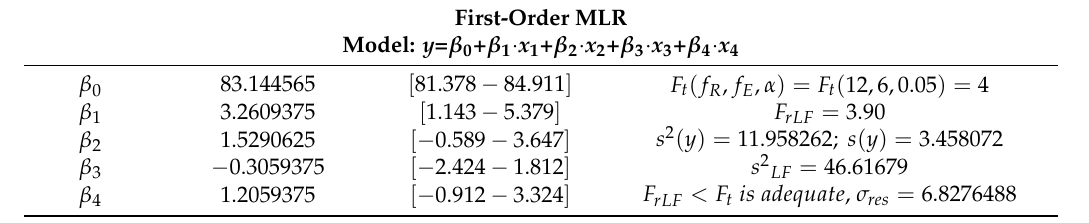
Table 3. Multiple Linear Regression (MLR) models, regression coefficients and their 95% confidence interval, F -test values, as well as the standard deviation of residuals σ res